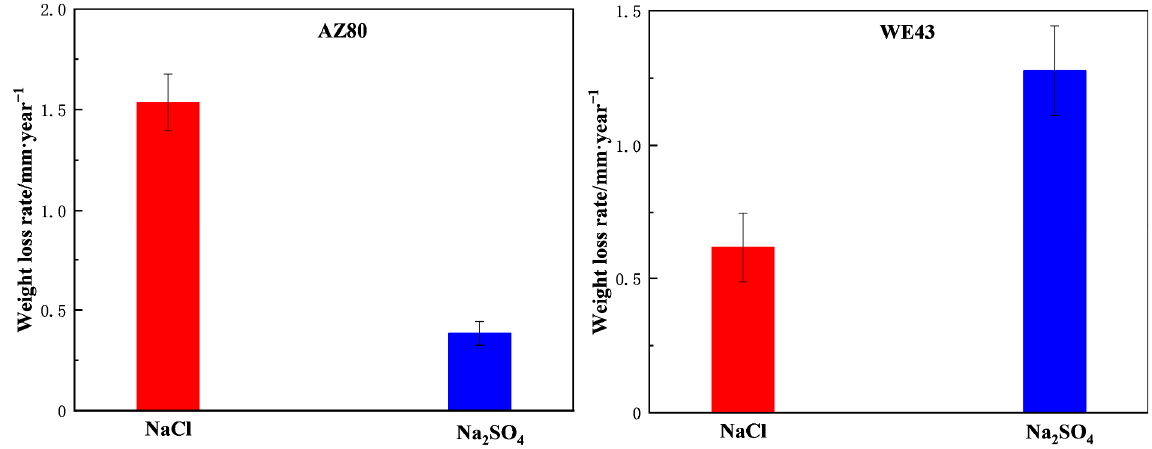
Figure 9. The weight loss rate (P m ) of AZ80 and WE43.